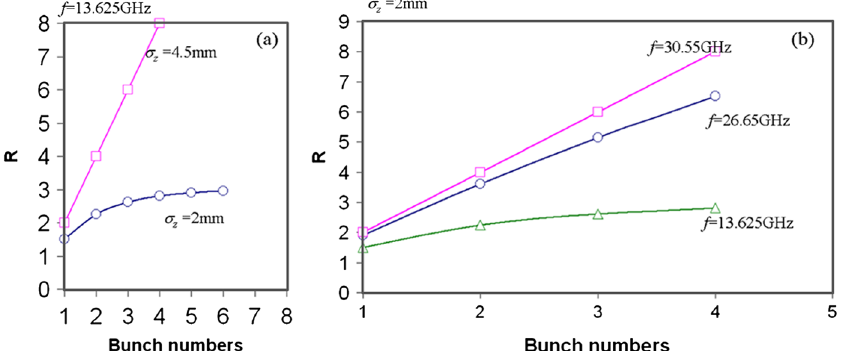
FIG. 3. Transformer ratio for an RBT. R as a function of bunch length and number of bunches for the dielectric wakefield accelerator used in the experiment. (a) R is enhanced in a 13.625 GHz dielectric-loaded accelerator when driven by a longer bunch length ( (cid:2) z ¼ ¼ 2 mm , the current AWA drive gun). (b) For the 4 : 5 mm , representative of the old AWA drive gun) compared to a shorter bunch ( (cid:2) z current AWA facility, (cid:2) z ¼ 2 mm and R can be increased by choosing the correct structure operating frequency. (Note that calculations are based on the single mode wakefield excitation. Shorter bunch lengths may lead to higher order mode excitation inside the structure which will result in slightly different values.)